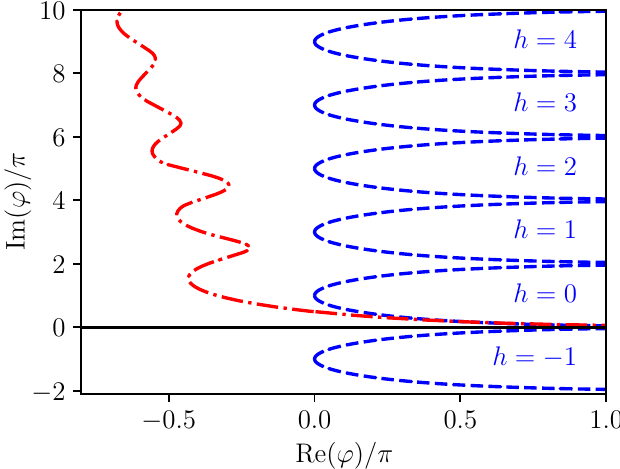
Figure 1 . Integration cycles of the Gamma function integral (2.1) in the complex plane. The integral converges on the black solid line ϕ ∈ R when Re( n ) < 0 . In that case R is also a Lefschetz thimble. The blue dashed curves are the elementary cycles, indexed by h ∈ Z . The integral is always convergent on the elementary cycles, and gives essentially an inverse Gamma function (2.4). These are equivalent to the thimbles for Re( n ) > 0 . Finally the red curve is a thimble when n = e − i θ for θ = π/ 2 − 0 . 01 , at the vicinity of a Stokes